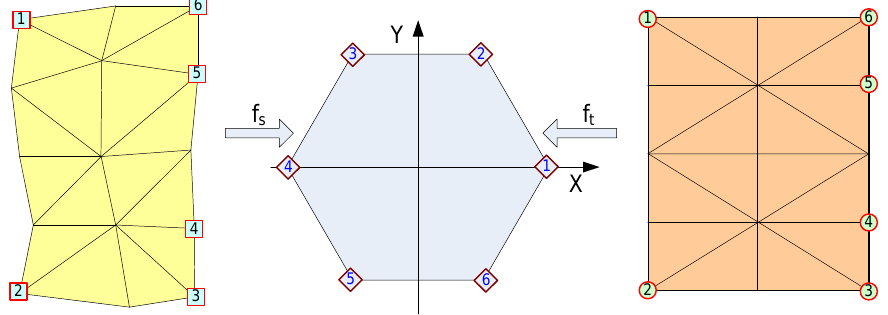
Figure 6. Parameterizations to the unit regular k